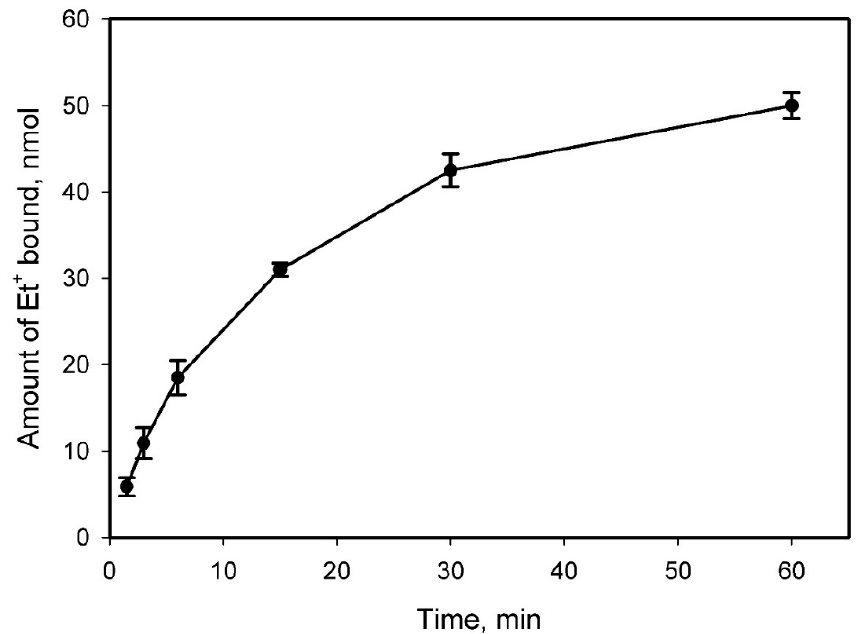
Figure 4. The dependence of the amount of Et + bound to DNA on the concentration of this cation in the medium. In total, 100 µg of salmon sperm DNA was added to various concentrations of Et + containing 100 mM Tris/HCl buffer, pH 8. The experiment was performed at 37 °C.